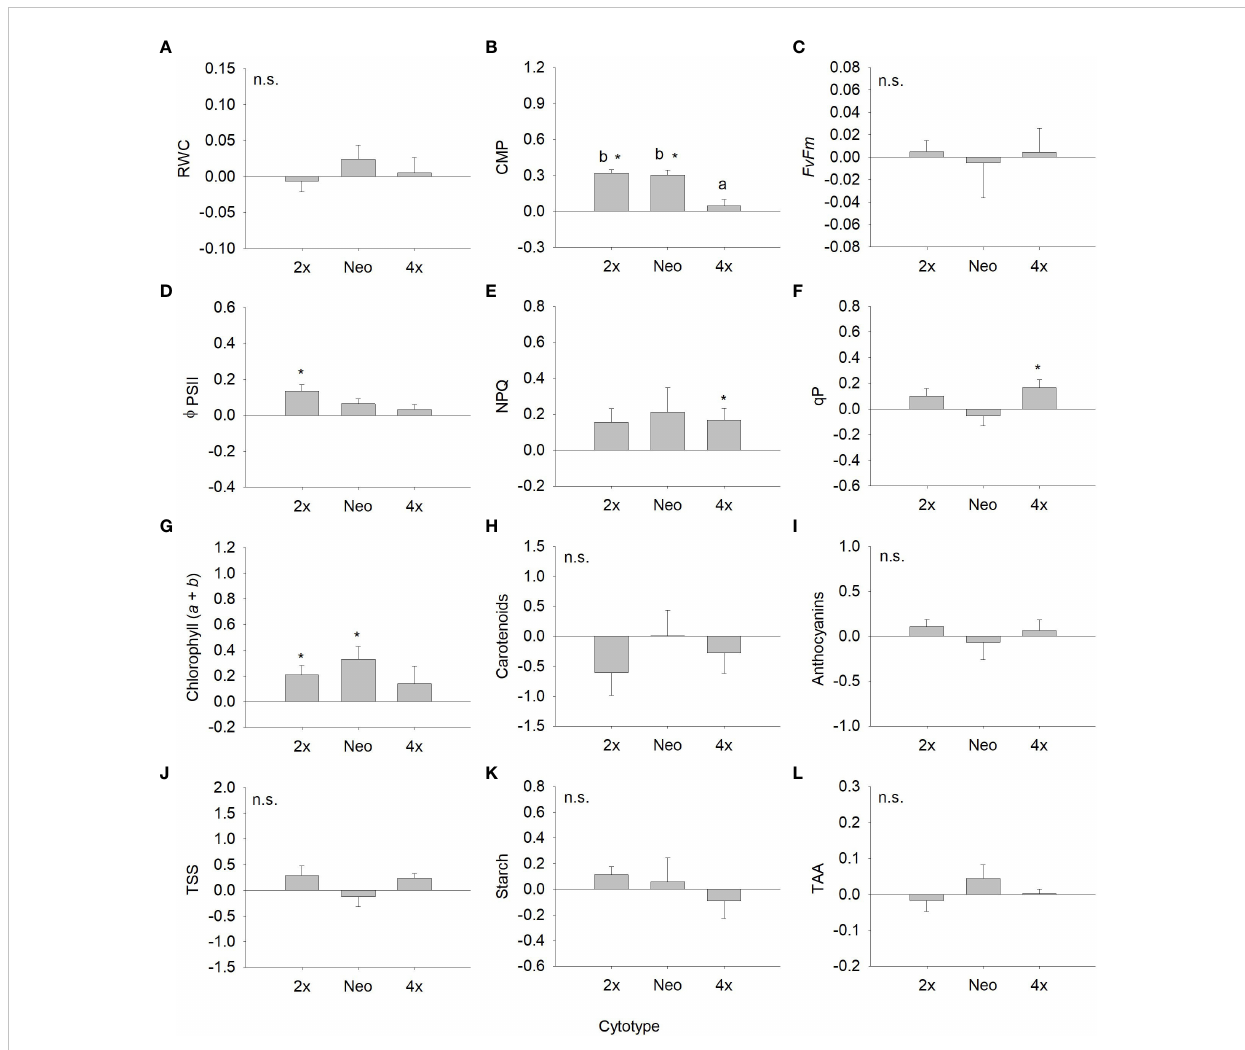
FIGURE 4 Response ratio (mean ± SE) for relative water content (A) , cell membrane permeability (B) , maximum quantum ef fi ciency of photosystem II (C) , effective quantum ef fi ciency of PSII (D) , non-photochemical quenching (E) , photochemical quenching (F) , chlorophyll ( a+b ) (G) , carotenoid content (H) , anthocyanin ’ s content (I) , total soluble sugars (J) , starch content (K) and total antioxidant capacity (L) of diploids, neotetraploids and tetraploids Jasione maritima var maritima of contact zone populations. Signi fi cant differences at P < 0.05 among cytotypes are indicated by different letters. The presence of * indicates that the response ratio differed signi fi cantly from